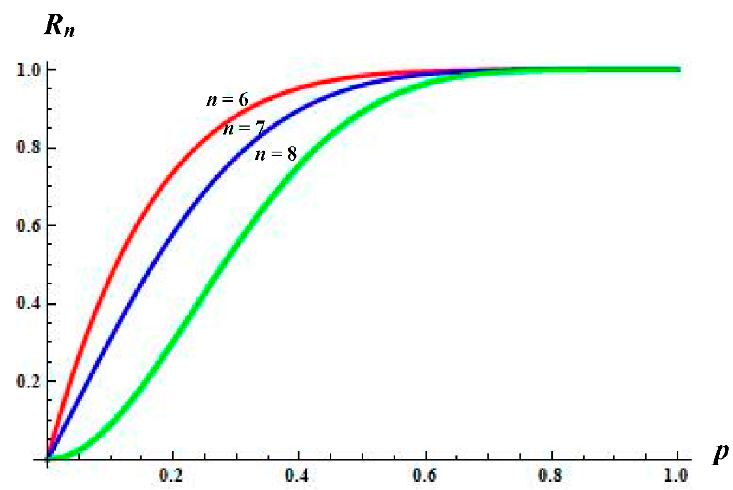
Figure 3. The reliability polynomial of the linear consecutive-2 and 4-out-of- n systems ( n = 6,7,8).